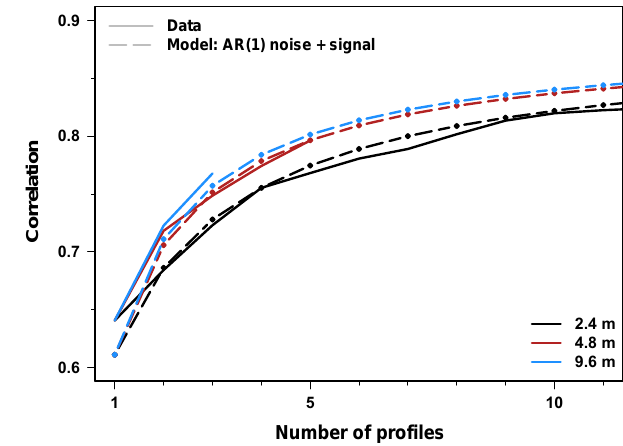
Figure 6. Observed and modelled inter-profile correlation as a function of profile spacing for T1. Observations for a given spac- ing are the mean across all possible profile pairs. Shading denotes the standard error of the mean assuming maximum degrees of free- dom (DOF) of N = 12 (estimated from the effective DOF of the horizontal trench data accounting for autocorrelation).